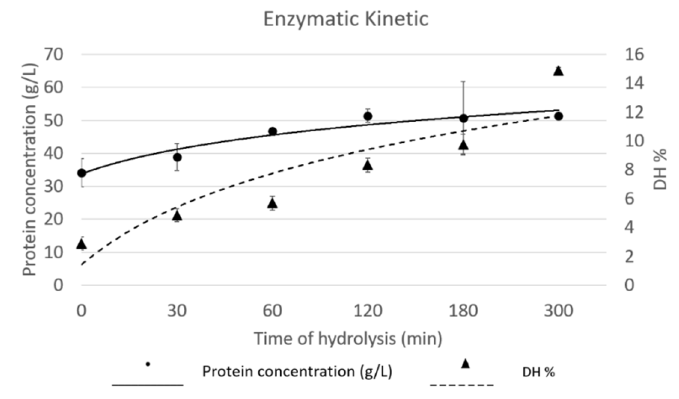
Figure 1. Enzymatic kinetic described by protein concentration (g/L) and DH% of hydrolysates collected at different time points.